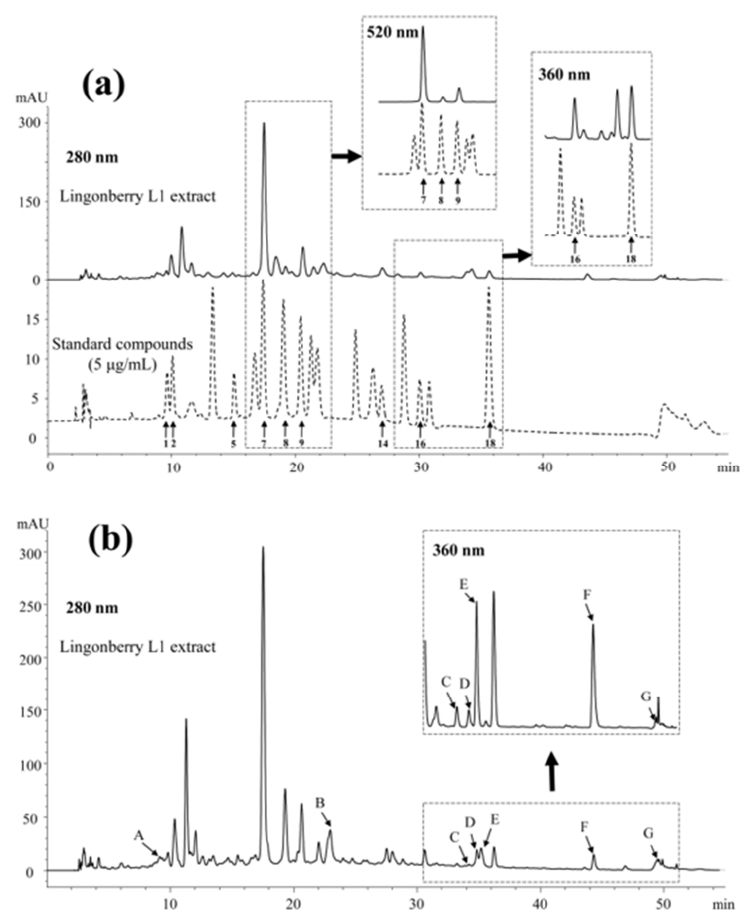
Figure 2. Chromatograms of lingonberry L1 extract and flavonoid standards (5 µ g / mL) at 280 nm. ( a ) Flavonoids quantified using authentic standards. Peak numbers (1–18) refer to compounds listed in Table 1. ( b ) Flavonoids tentatively identified and quantified. A, B-type procyanidin; B, A-type procyanidin; C, quercetin-3- O -xyloside; D, quercetin-3- O -arabinoside; E, quercetin-3- O -arabino-furanoside; F, quercetin-3- O -(4”-HMG)-rhamnoside; G, kaempferol-(HMG)- rhamnoside. The concentration of flavonoids in lingonberry extract ranged from 1.5 to 101.9 µ g /